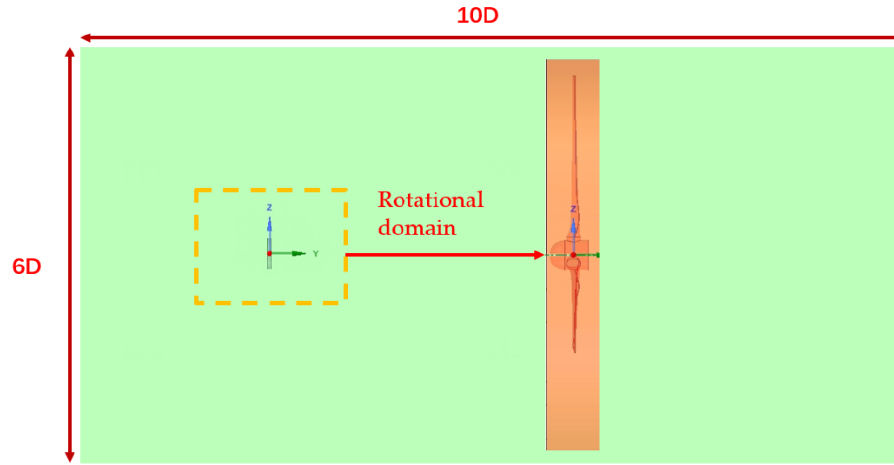
Figure 17. Rotational domain and stationary domain.